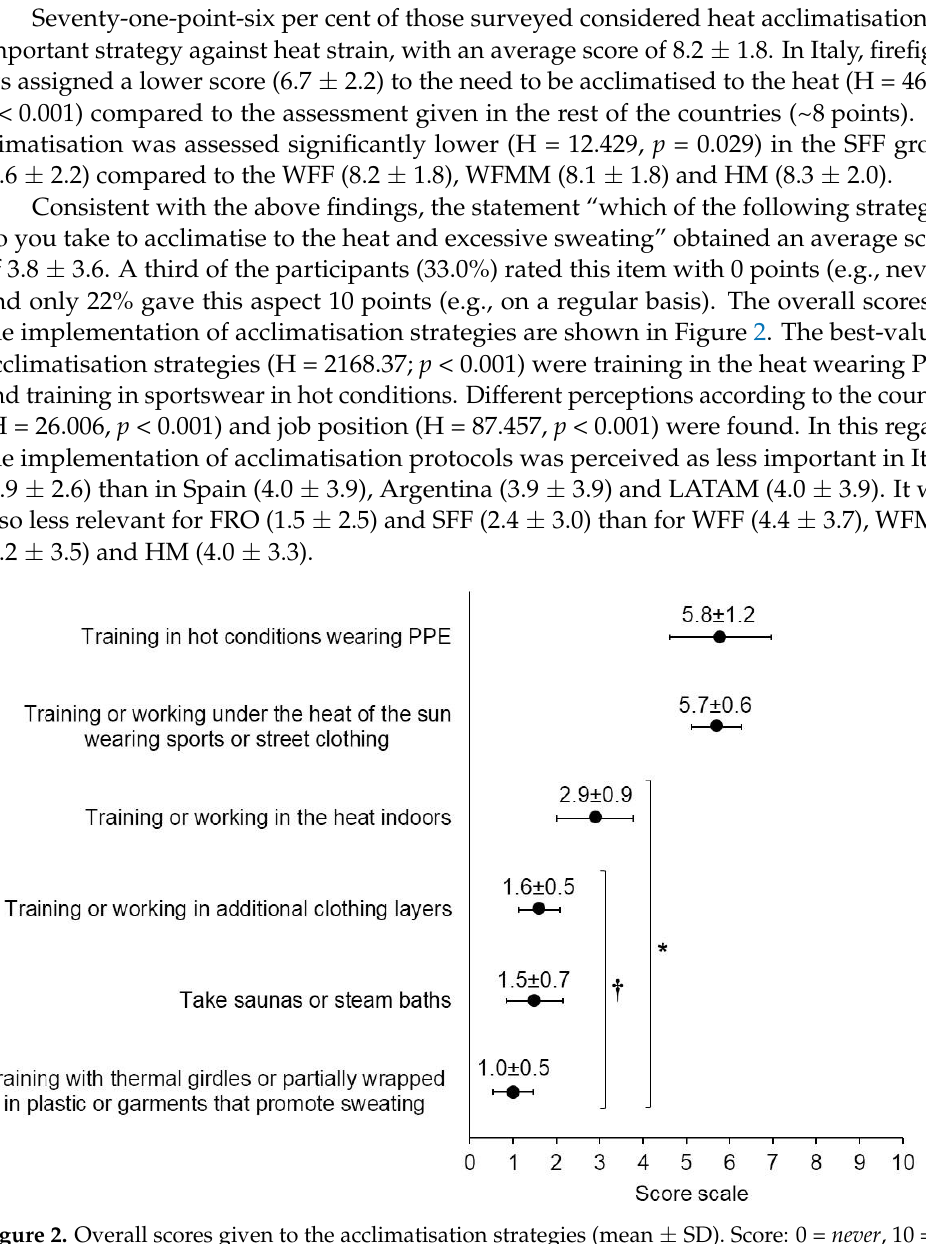
Figure 2. Overall scores given to the acclimatisation strategies (mean ± SD). Score: 0 = never , 10 = on a regular basis . *: differences between training in hot conditions wearing PPE and training under the heat of the sun wearing sports or street clothing; †: differences with training or working indoors with heat. All differences are significant at p < 0.001.